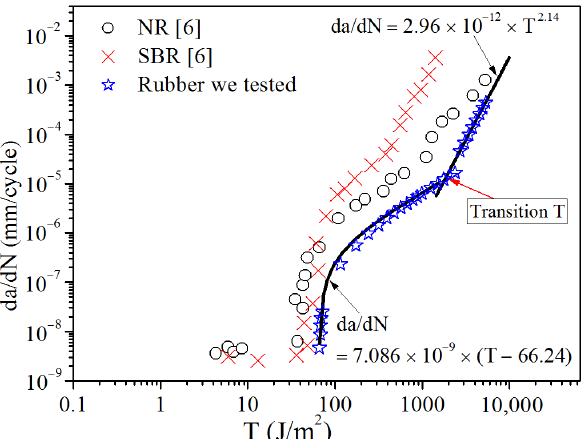
Figure 11. Relationship between crack propagation rate and maximum tear energy (in log-log coor- dinate).